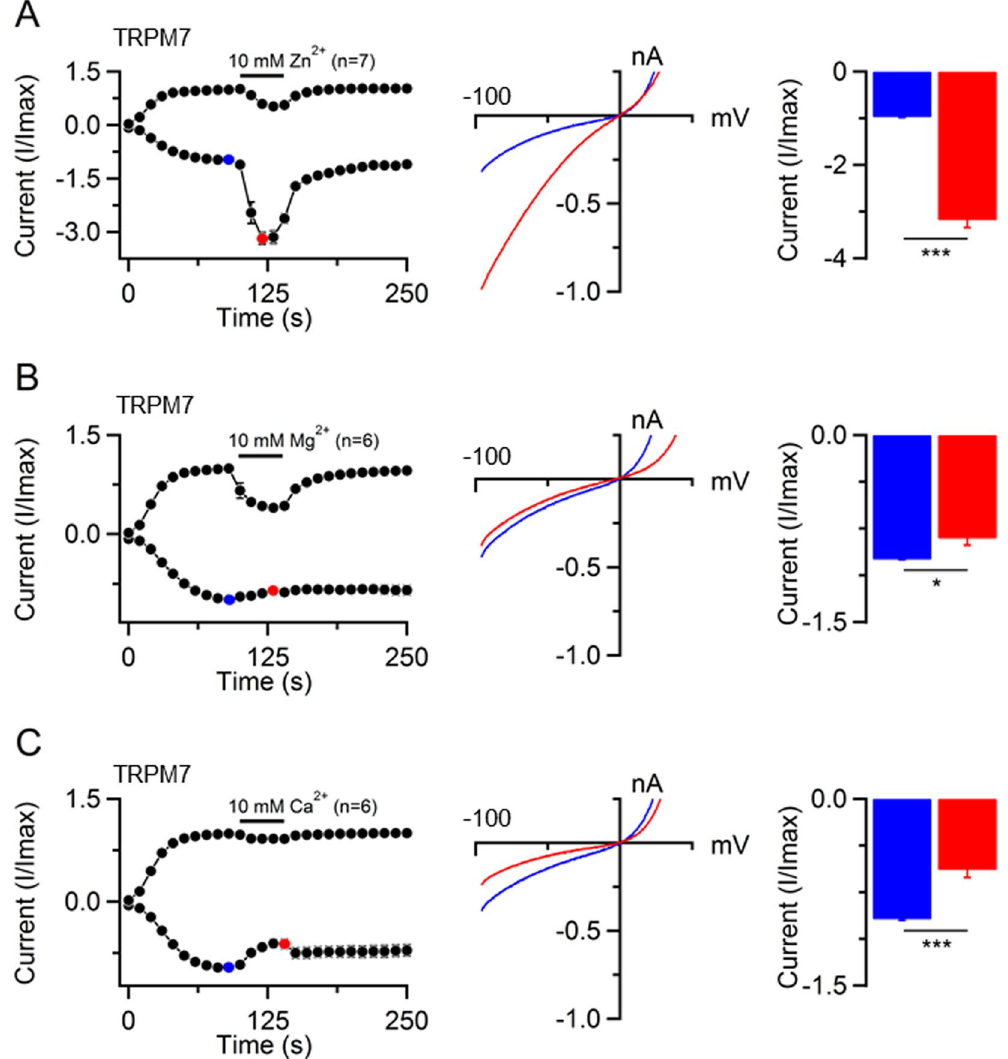
Figure 4. Examining of divalent cations permeability of mTRPM7. ( A ) Left panel: Whole-cell currents were recorded in mTRPM7-transfected HEK 293 cells using the standard [Mg 2 + ] i -free internal solution and standard external solution. When currents started to develop, cells were subsequently exposed to the external solution containing 10 mM Zn 2 + as indicated by a bar. Data are shown as I/Imax ± SEM (Imax value was obtained in a ramp before application of 10 mM Zn 2 + ). Middle panel : Representative I-V relationships of inward currents obtained before (blue) and during (red) application of 10 mM Zn 2 + as indicated in the Left panel . Right panel : Bar graphs of inward currents ( − 80 mV, mean I/Imax ± SEM) obtained before (blue) and during (red) application of 10 mM Zn 2 + as indicated in the Left panel . ( B , C ) Changes in the inward mTRPM7 currents by exposure of cells to external solutions containing 10 mM Mg 2 + ( B ) and 10 mM Ca 2 + ( C ). Measurements were performed similarly to ( A ). n, number of cells measured; * P < 0.05; *** P < 0.001 (two-tailed